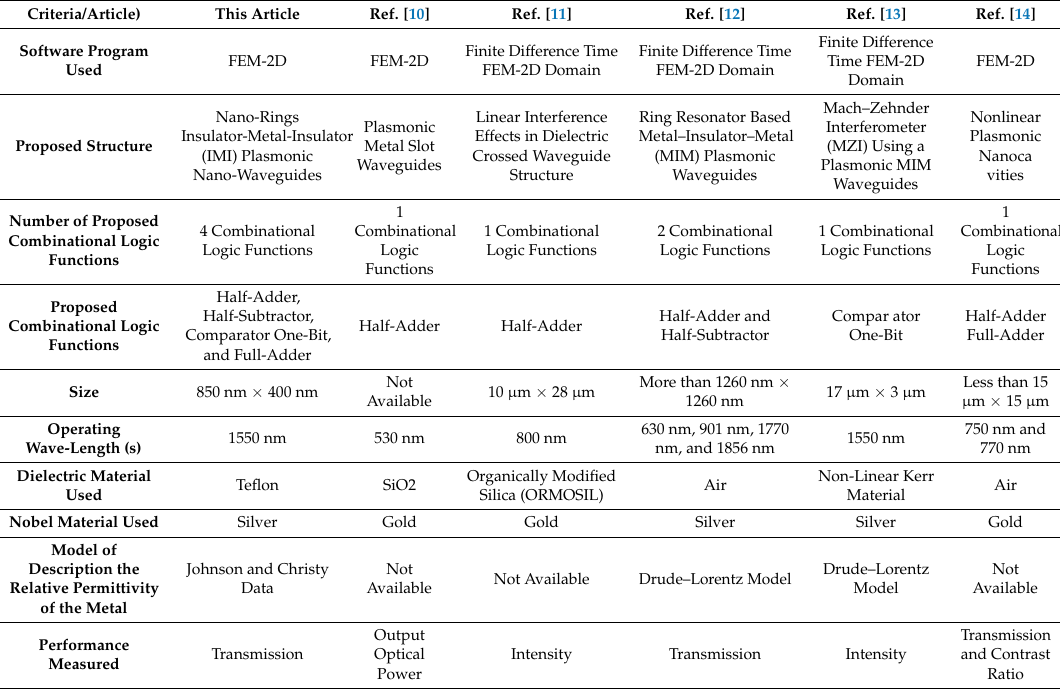
Table 6. Comparison between our proposed plasmonic combinational logic functions and previous